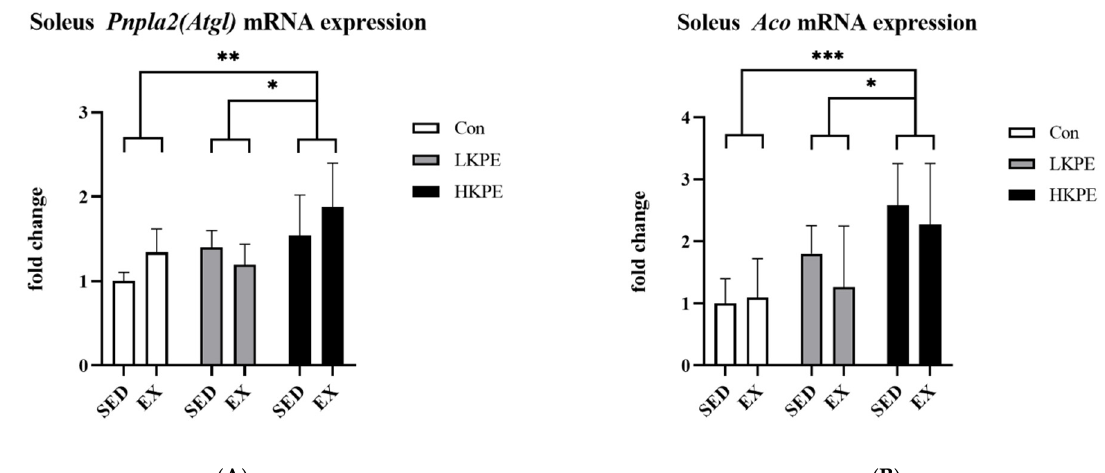
Figure 2. ( A ) Plasma glucose; ( B ) plasma triglyceride; ( C ) plasma FFA; ( D ) plasma total cholesterol; ( E ) plasma HDL; and ( F ) plasma LDL: concentrations immediately after exhaustion. FFA, free fatty acids; LDL, low-density lipoprotein cholesterol; HDL, high-density lipoprotein cholesterol; SED, sedentary; EX, exercise; Con, control; KPE, Kaempferia parviflora administration; ns, no significance observed.